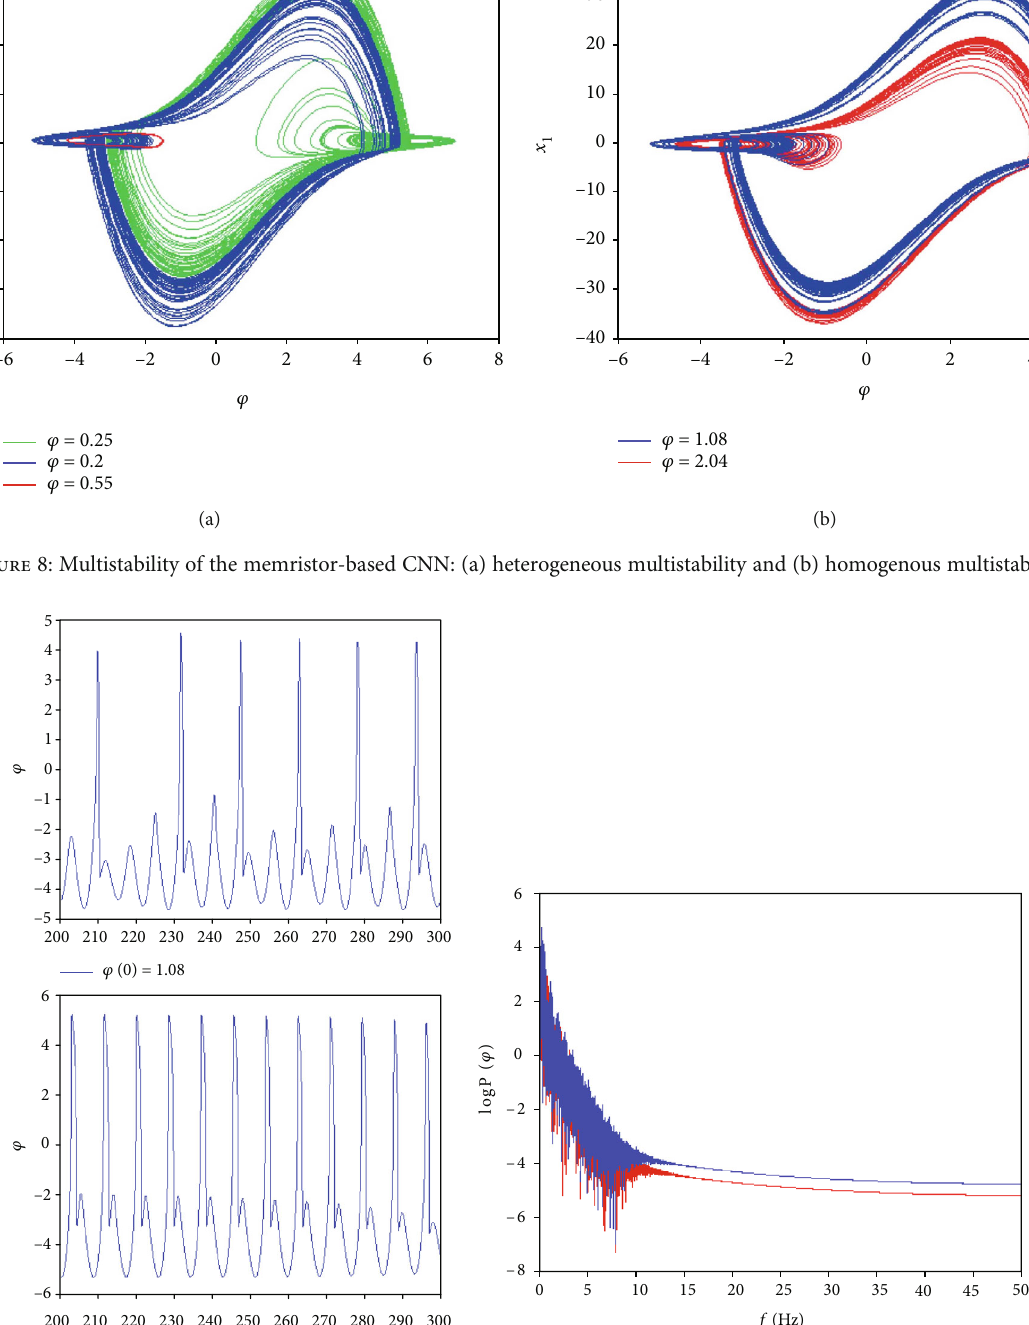
𝜑 (0) = 2.04 Figure 9: Time-domain waveforms and frequency spectra of the chaotic signals with φ ð 0 Þ = 1 : 08 and 2.04: (a) time-domain waveforms and (b) frequency